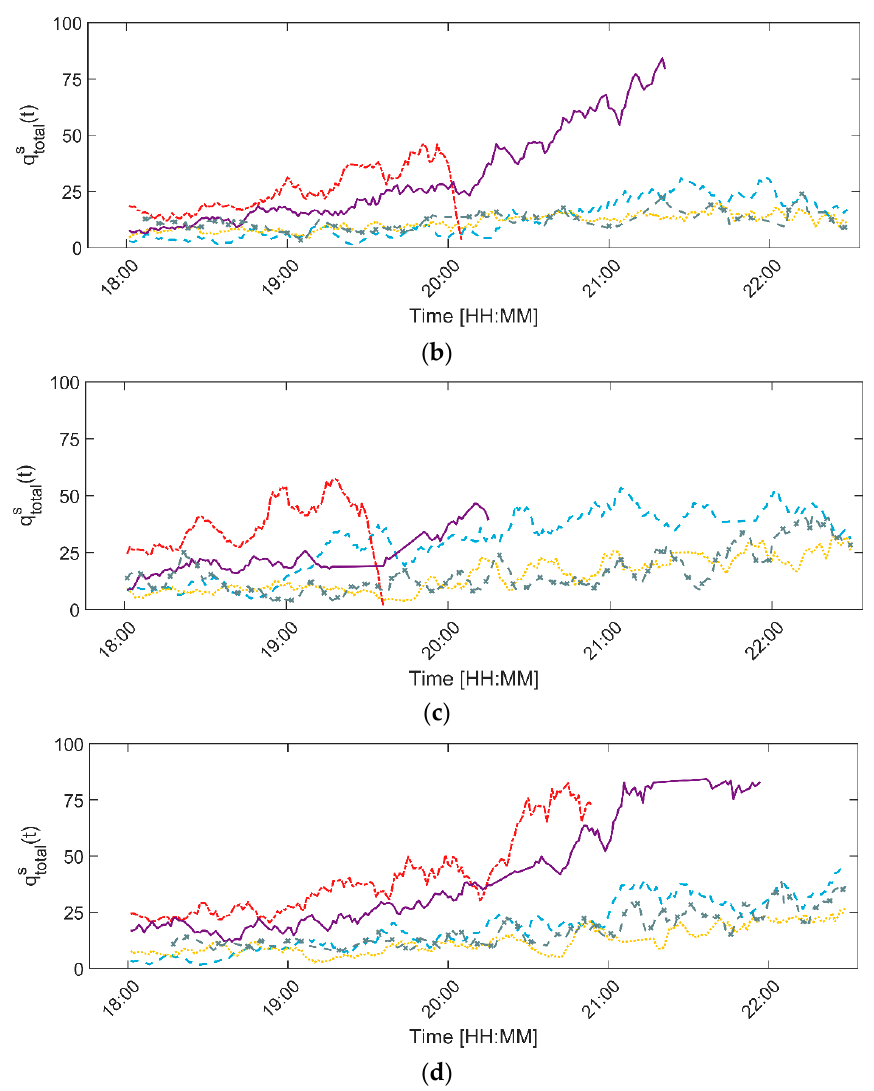
Figure 3. Flow rate time series per day and per location (c1–c5) for ( a ) Wednesday, ( b ) Thursday, ( c ) Friday and ( d ) Saturday.